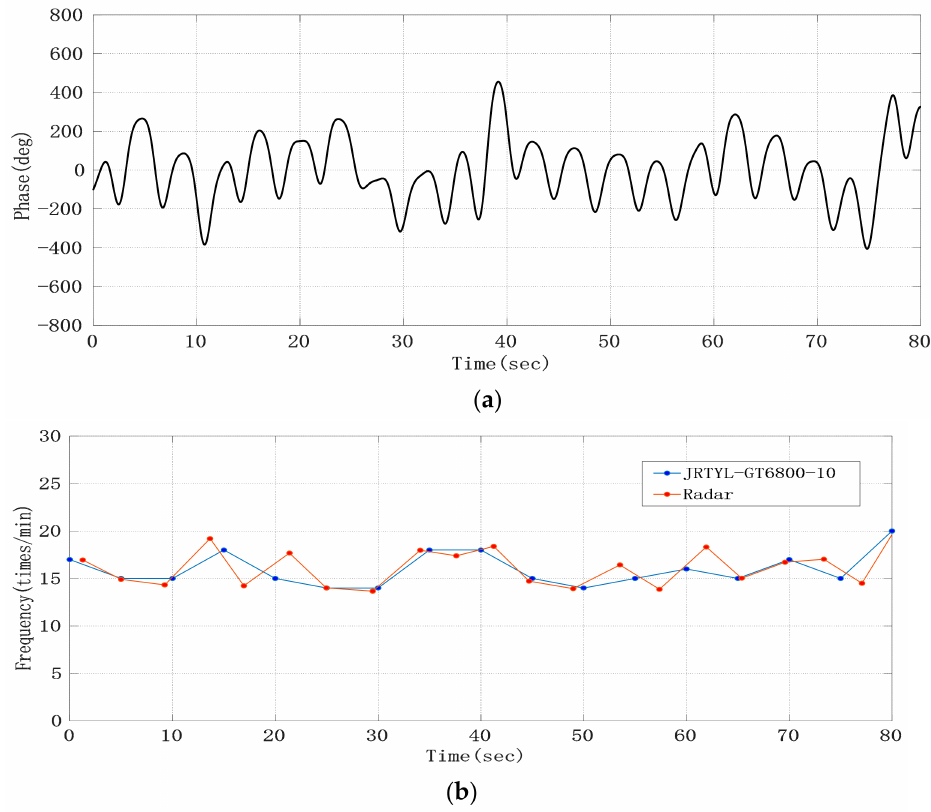
Figure 9. Experimental results; ( a ) respiratory signal after the Gaussian low-pass smoothing filter; ( b ) curve of respiratory rate changing with time.